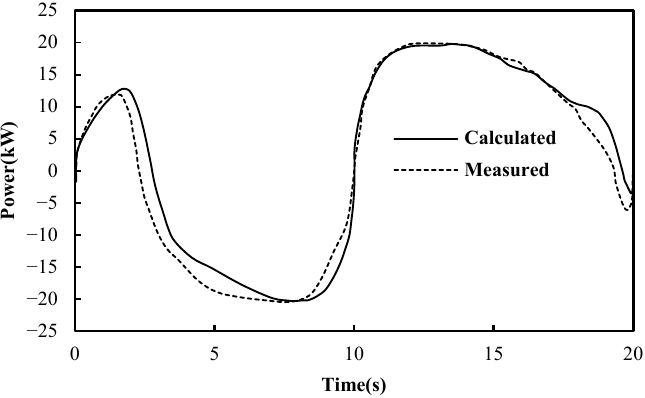
Figure 6. Measured electric power diagram. According to the measured dynamometer card of well X 1 (Figure 5), the calculated electric power diagram is compared with the measured electric power diagram (Figure 6) by using the calculation model, as shown in Figure 7.